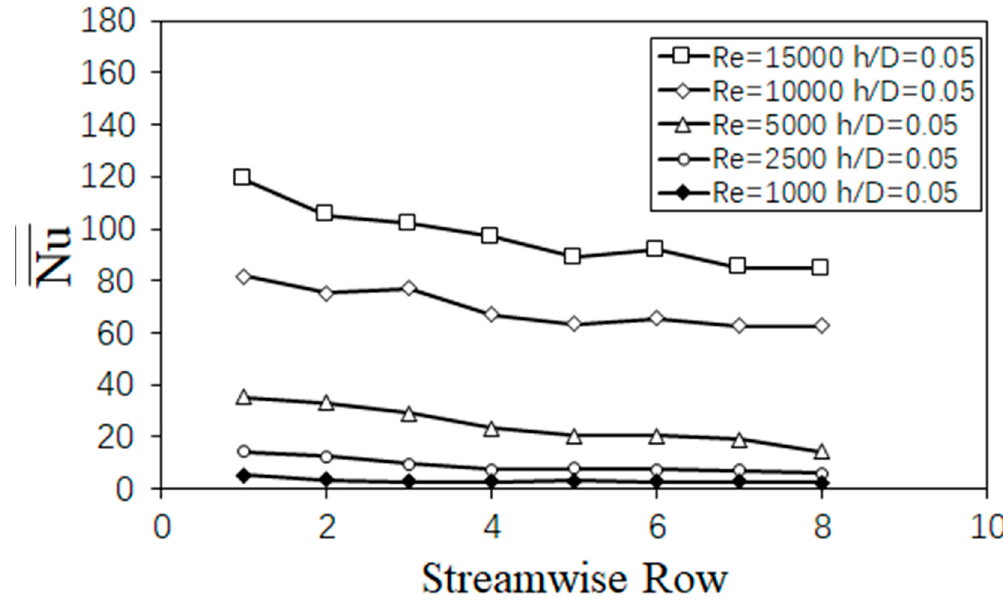
Figure 15. Spatially averaged Nusselt numbers as dependent upon streamwise row location, for different Re j , for micro cooling units height of 0.05 D.